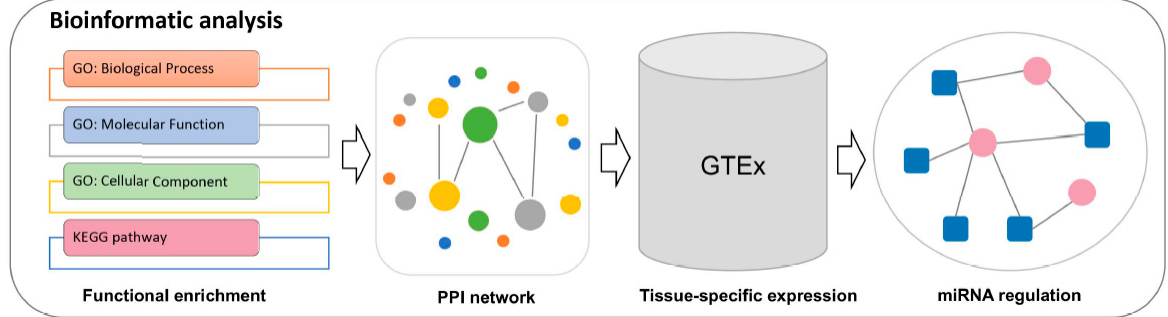
Figure 2. Bioinformatic analysis of the identified amelogenesis imperfecta-related genes, including functional enrichment analysis, construction of amelogenesis imperfecta-related protein interaction network, tissue-specific expression of amelogenesis imperfecta-related genes, and construction of miRNA–gene regulations.